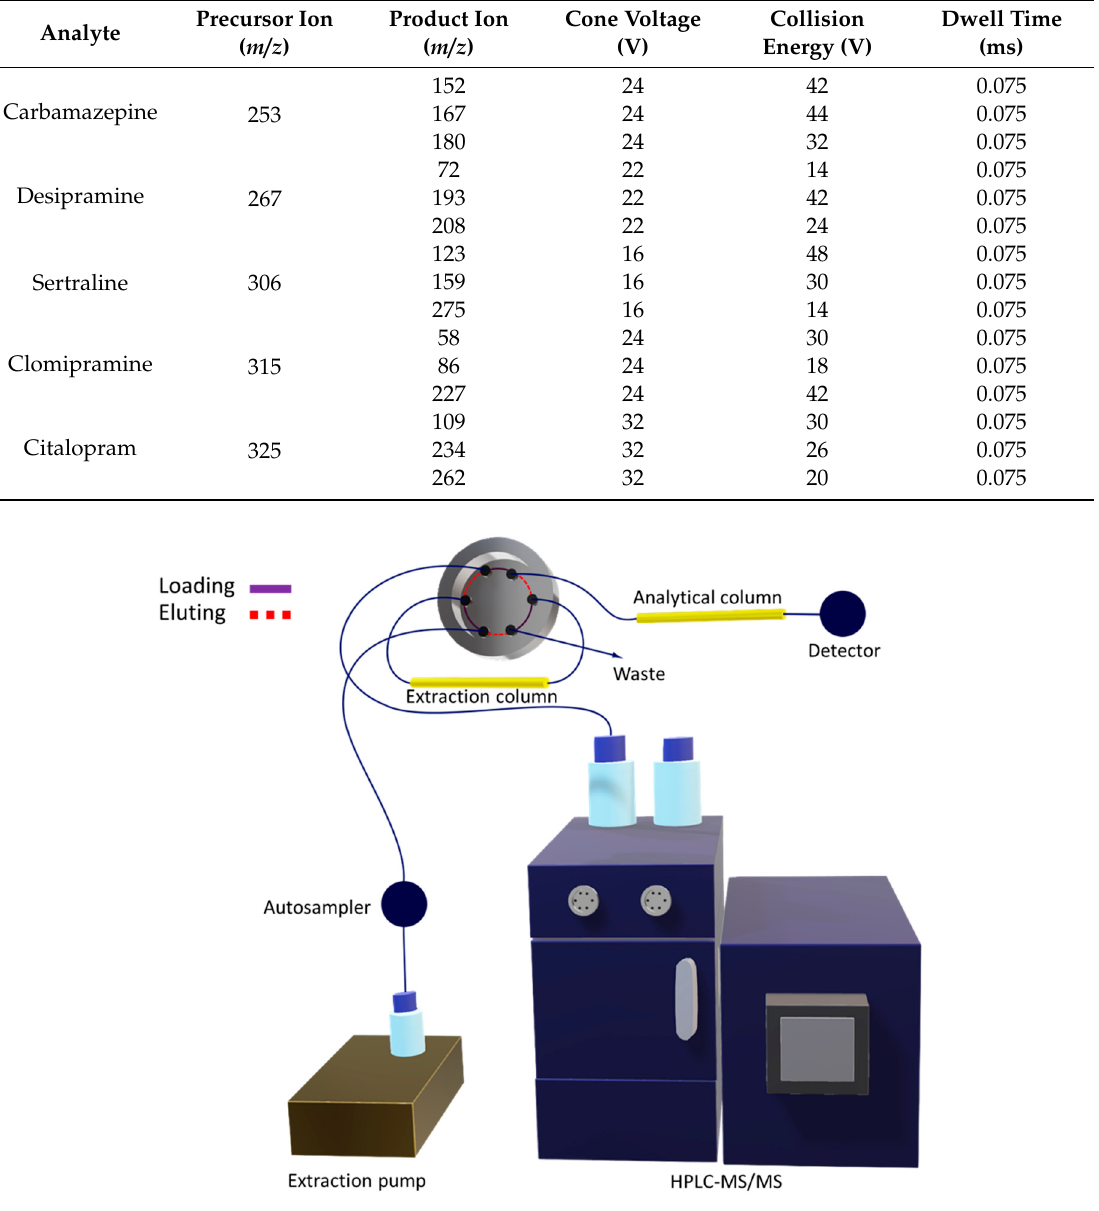
Figure 5. Illustrative drawing representing the multidimensional configuration, including the extraction column (first dimension) connected to the analytical column (second dimension) via a switching valve placed before the HPLC-MS/MS instrument.